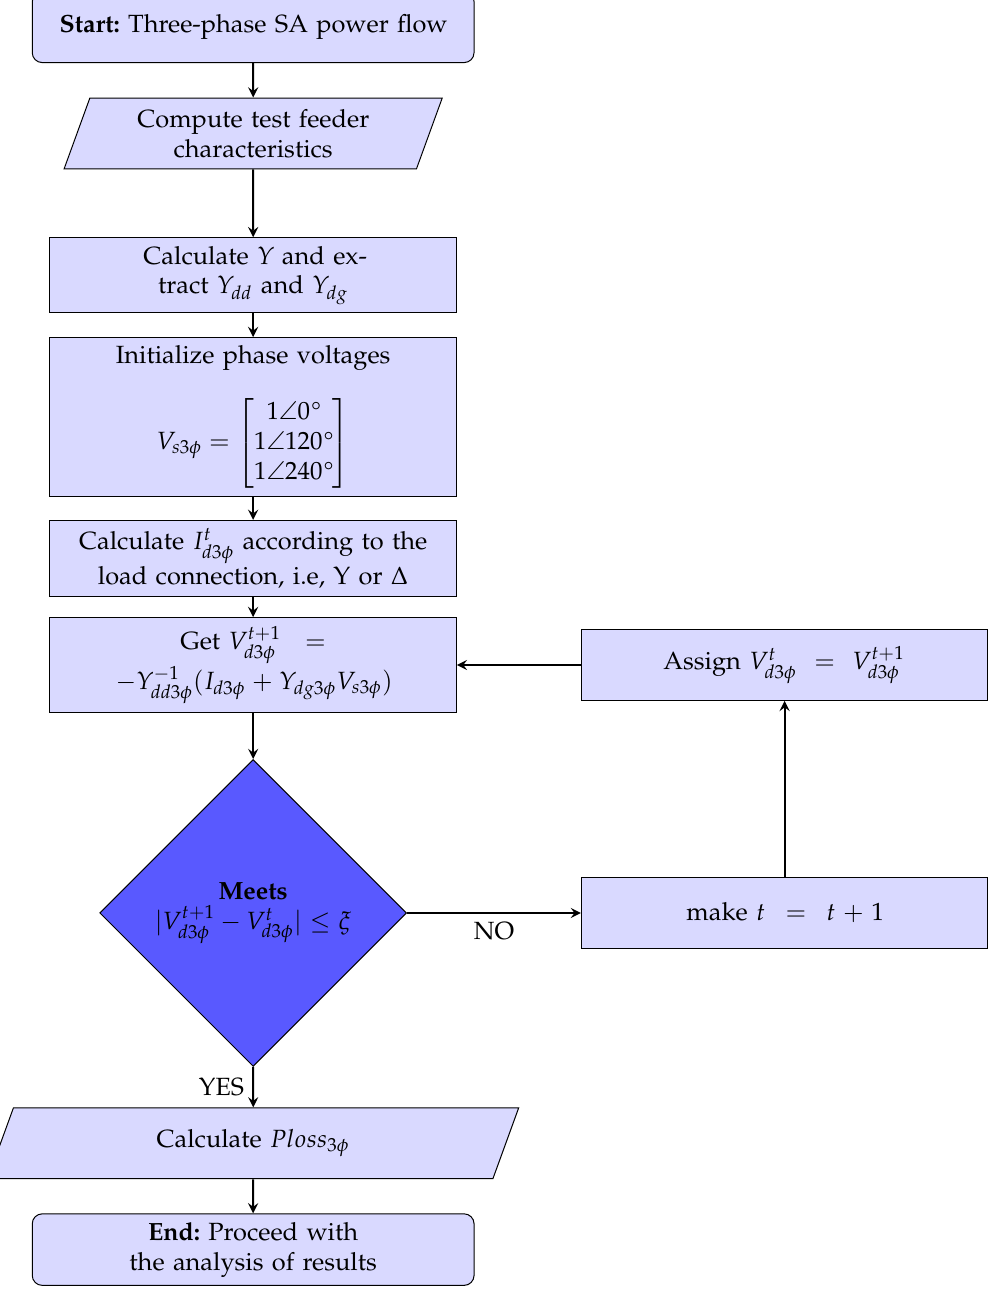
Figure 1. Flowchart for the SA